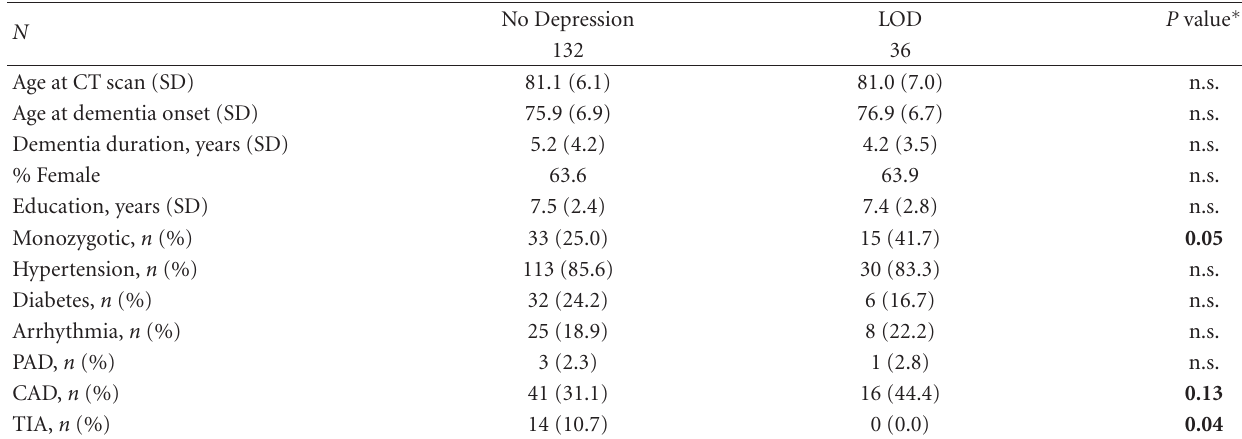
Table 2: Sample demographics by depression group.